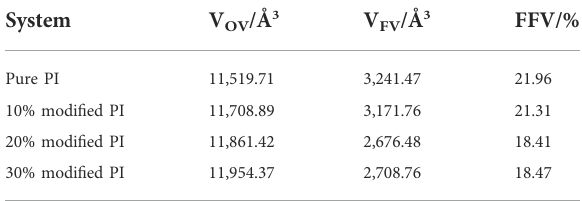
TABLE 1 V vv , V ov , and FFV of each system